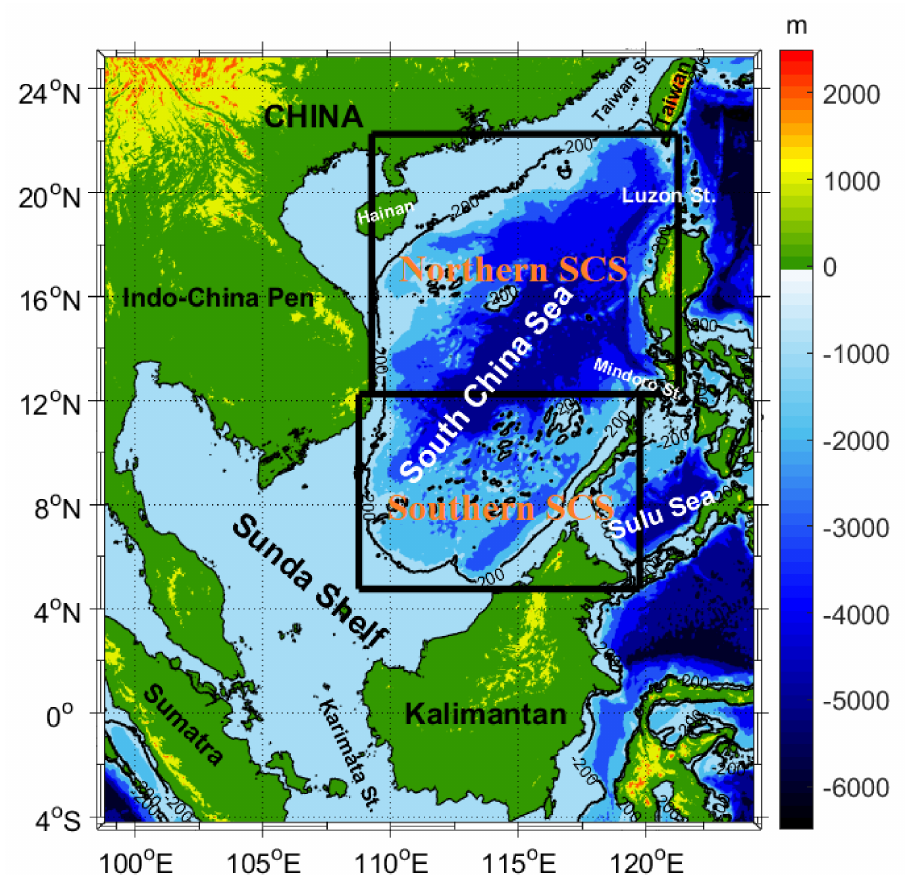
Figure 1. Bathymetry of the South China Sea (the data are from ETOPO1). The black rectangular boxes denote the coverage area of the northern and southern South China Sea